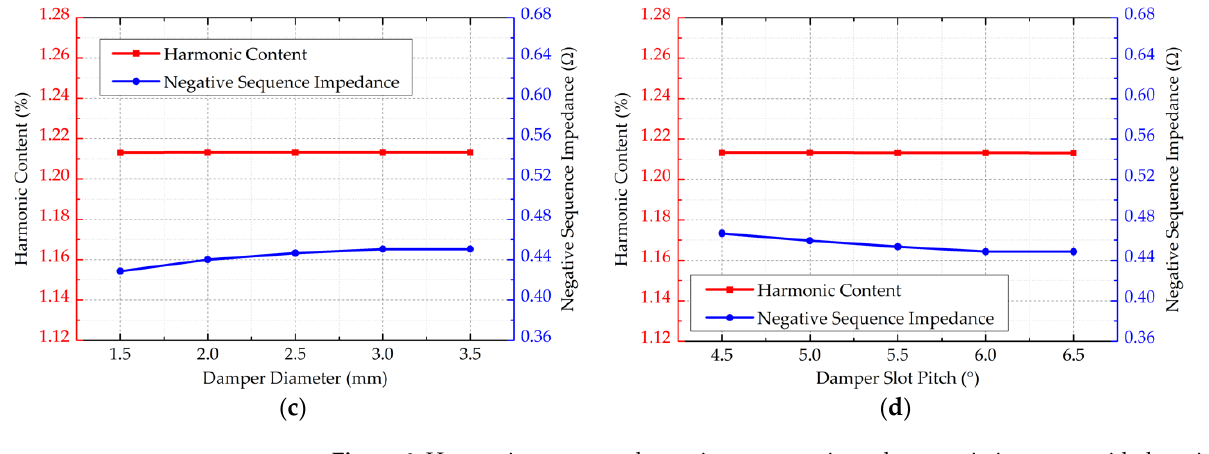
Figure 6. Harmonic content and negative sequence impedance variation curve with damping winding parameters: ( a ) Effect of damper slot opening; ( b ) Effect of damper slot opening height; ( c ) Effect of damper diameter; ( d ) Effect of damper slot pitch.